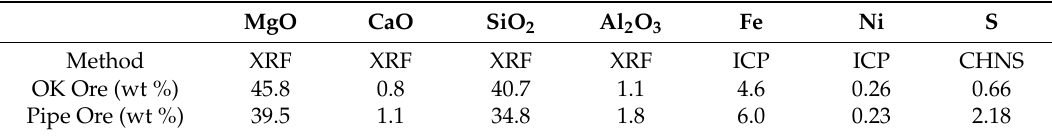
Table 1. Elemental composition of OK and Pipe